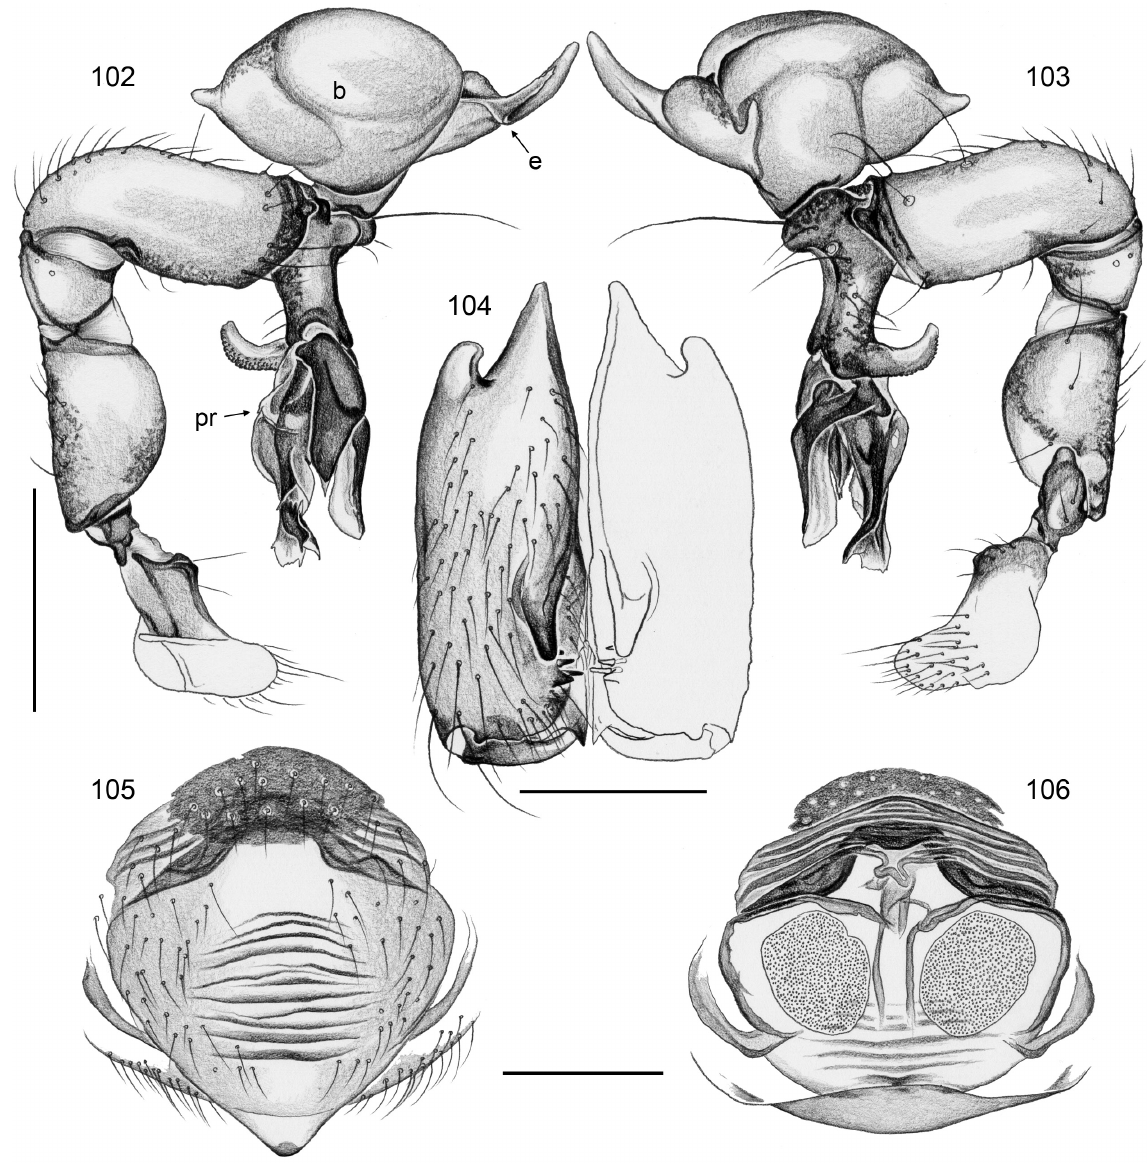
Figs 102-106. Spermophora kirinyaga sp. nov. 102-103. Left ♂ palp, prolateral and retrolateral views. 104. ♂ chelicerae, frontal view. 105-106. ♀ genitalia, ventral and cleared dorsal views. b: genital bulb; e: embolus; pr: procursus. Scale lines: 0.2 mm (104), 0.3 mm (105-106), 0.5 mm